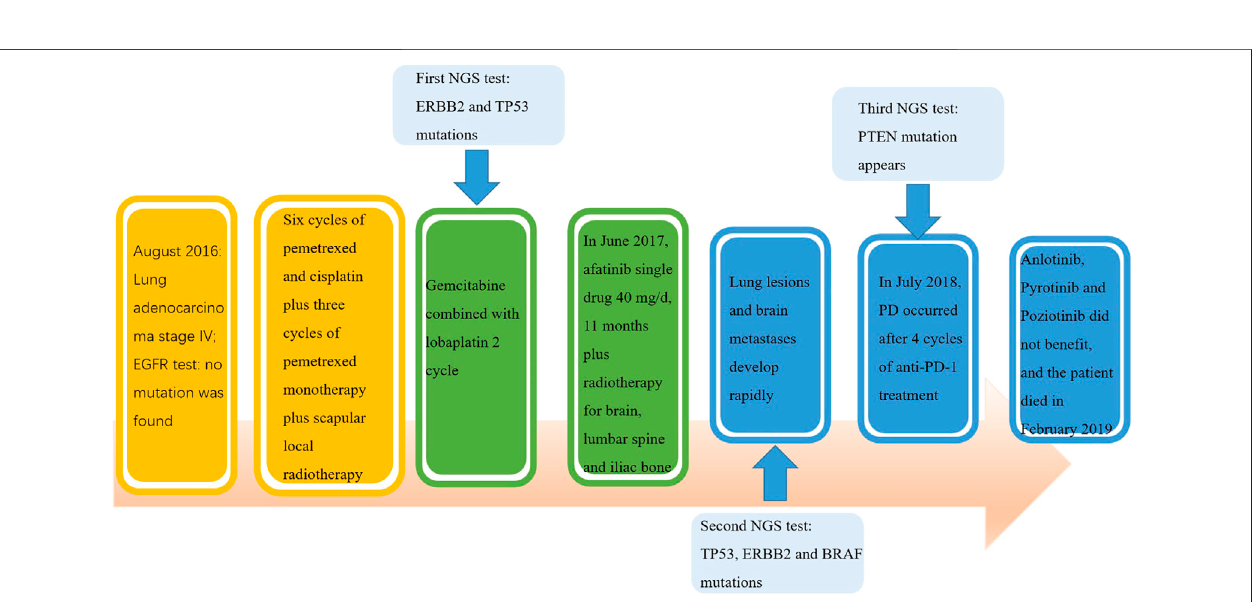
FIGURE 2 | The whole course of treatment of the